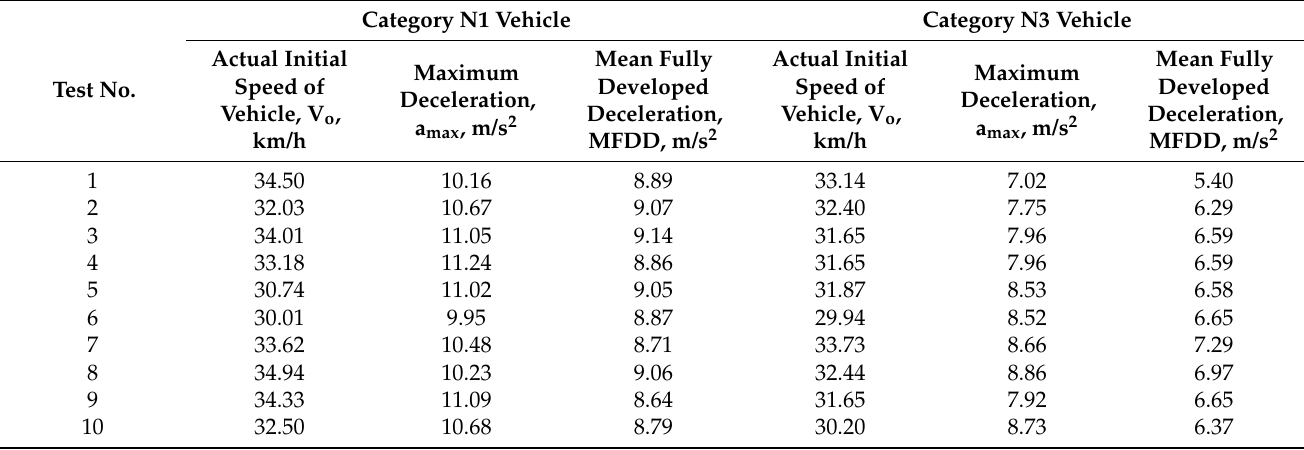
Table 3. Parameters of the braking process on a wet asphalt pavement from 30